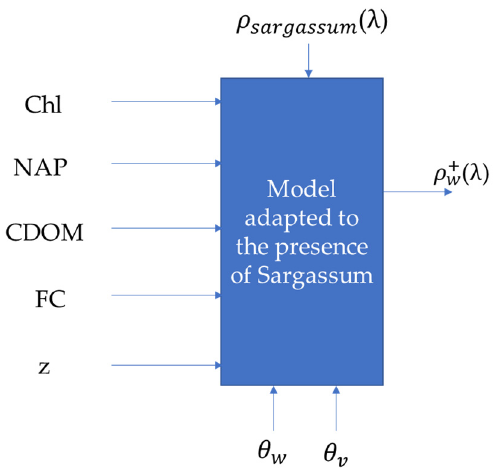
Figure 3. Inputs and output of the SRT model.